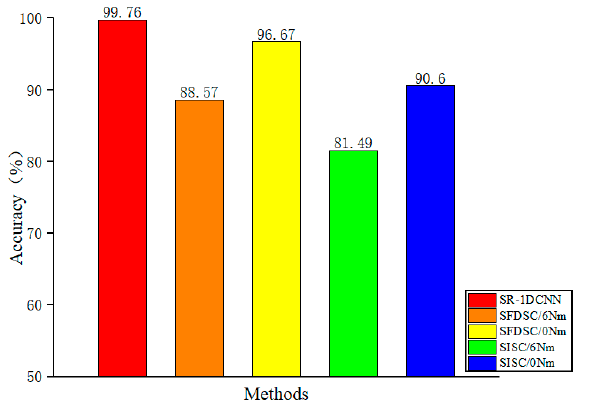
Figure 19. Comparison of different methods (test set of Worm Gear